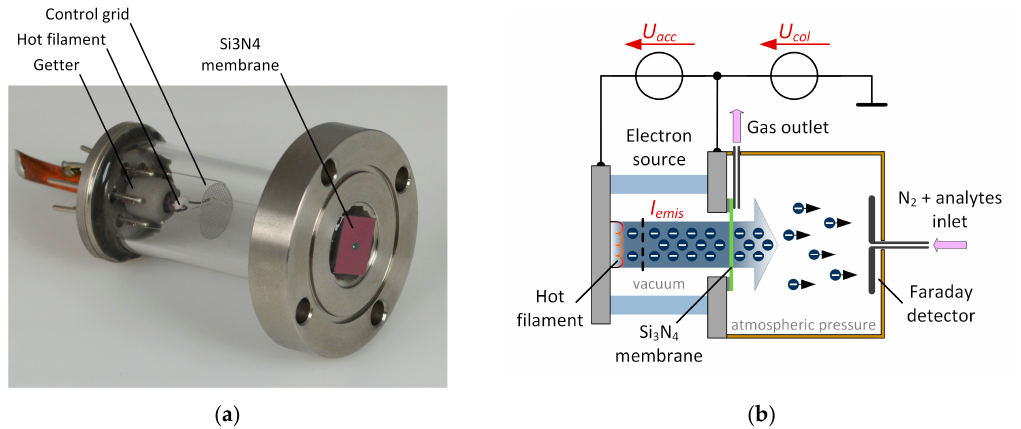
Figure 1. Photo of our hermetically sealed non-radioactive electron source based on thermionic electron emission ( a ) and concept of the electron capture detector with axial gas flow ( b ) employing the non-radioactive electron